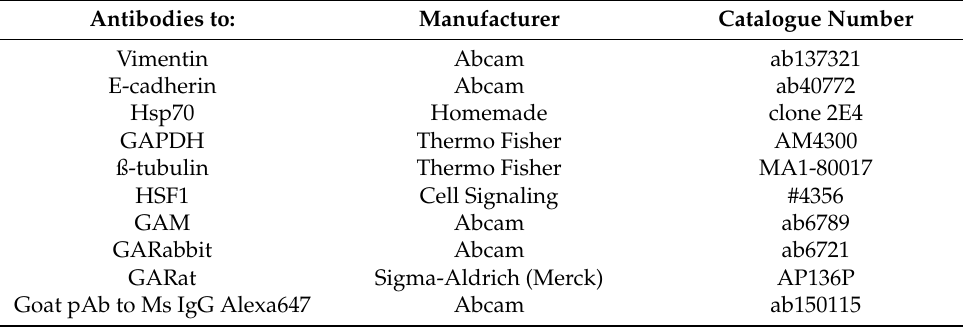
Table 1. The primary and secondary antibodies used in the